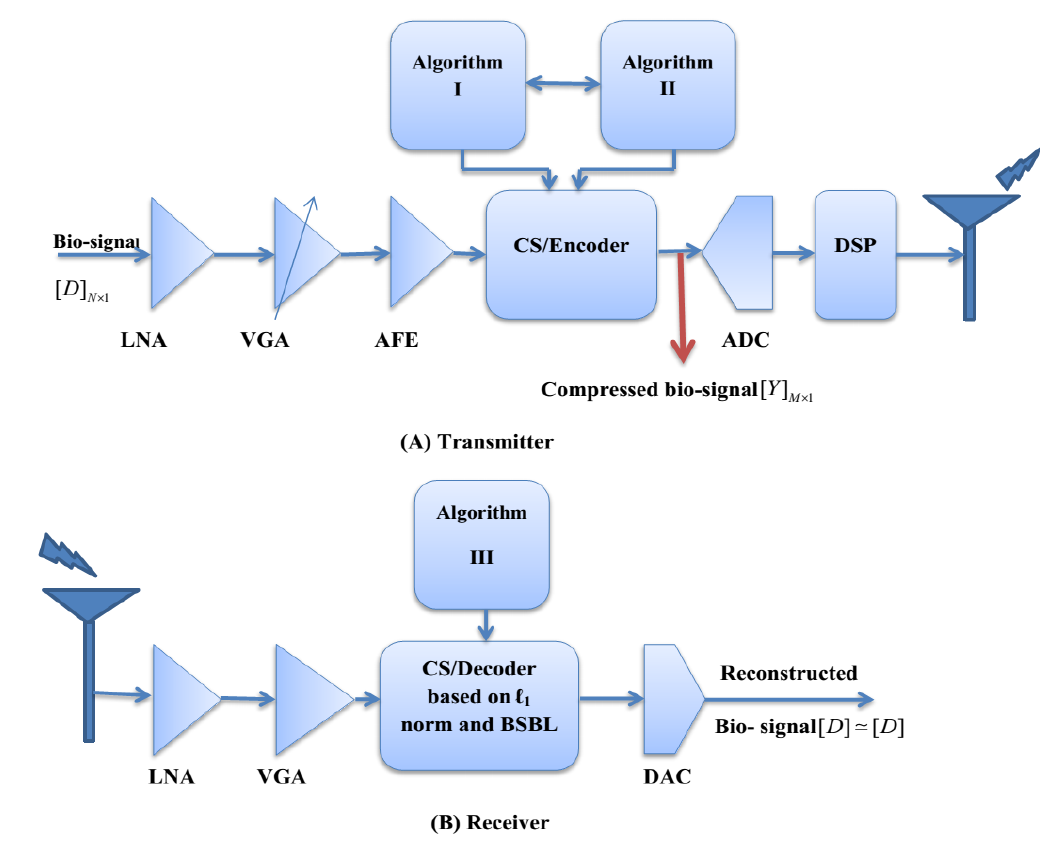
Figure 2. The proposed system architecture ( A ) Transmitter ( B )